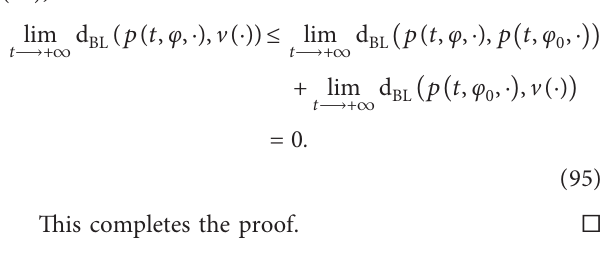
( u ) � 1 . 6876 . Both species y 2